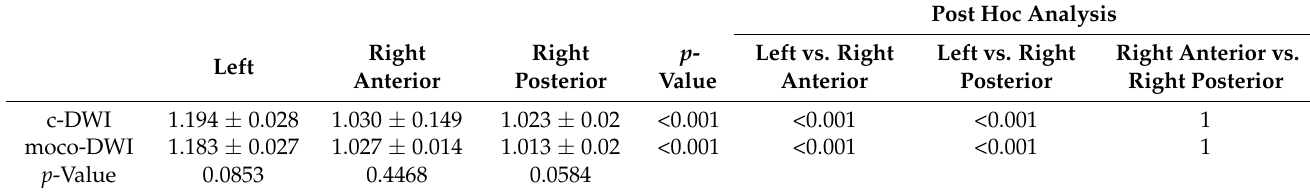
Table 3. Comparison of ADC measurement in liver parenchyma between c-DWI and moco-DWI. .